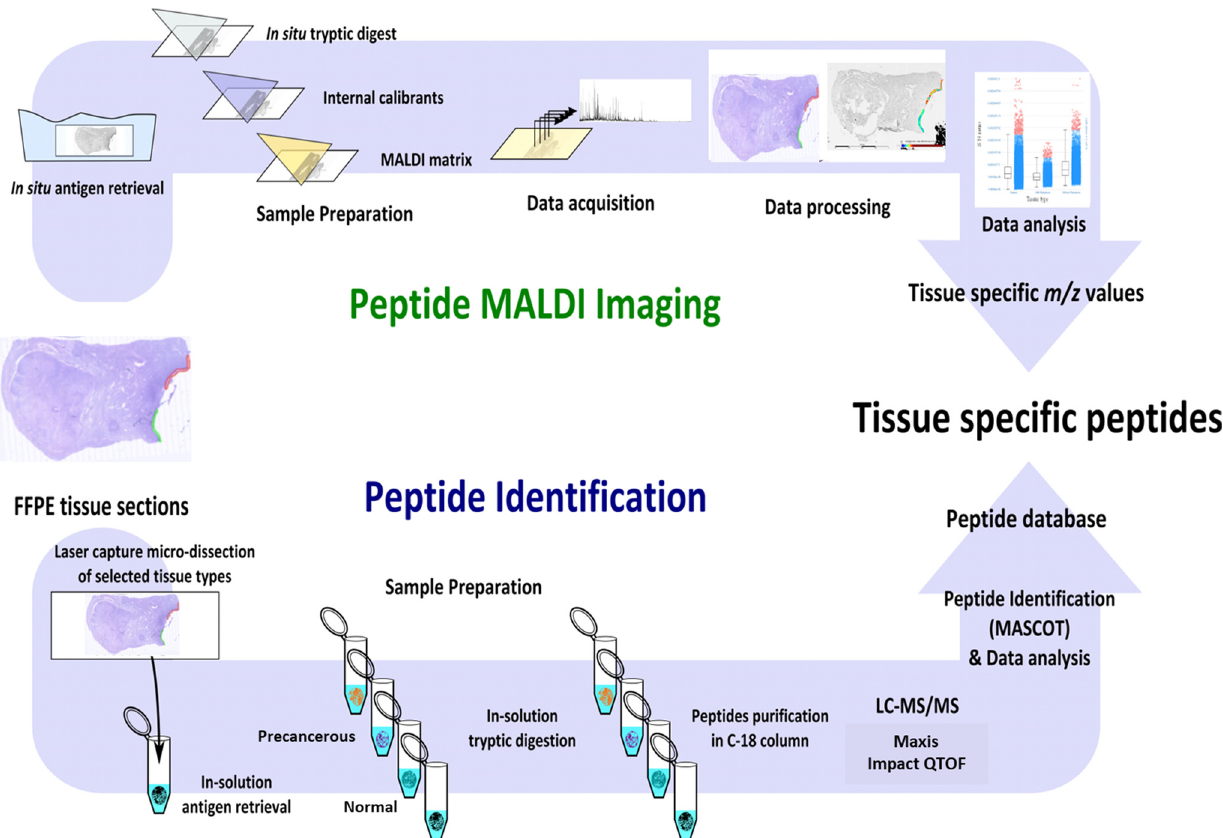
Figure 1. (Adapted with permission from from G. Arentz et al. (2017) [18]): Workflow of proteomic analysis of small precancerous regions extracted from FFPE tissue. Peptide MALDI Imaging:MALDI MSI workflow to acquire spatially defined molecular information. Peptide Identification: LCM extraction of precancerous regions followed by LC-MS/MS analysis for the identification of proteins differentially expressed between healthy and precancerous tissue regions.